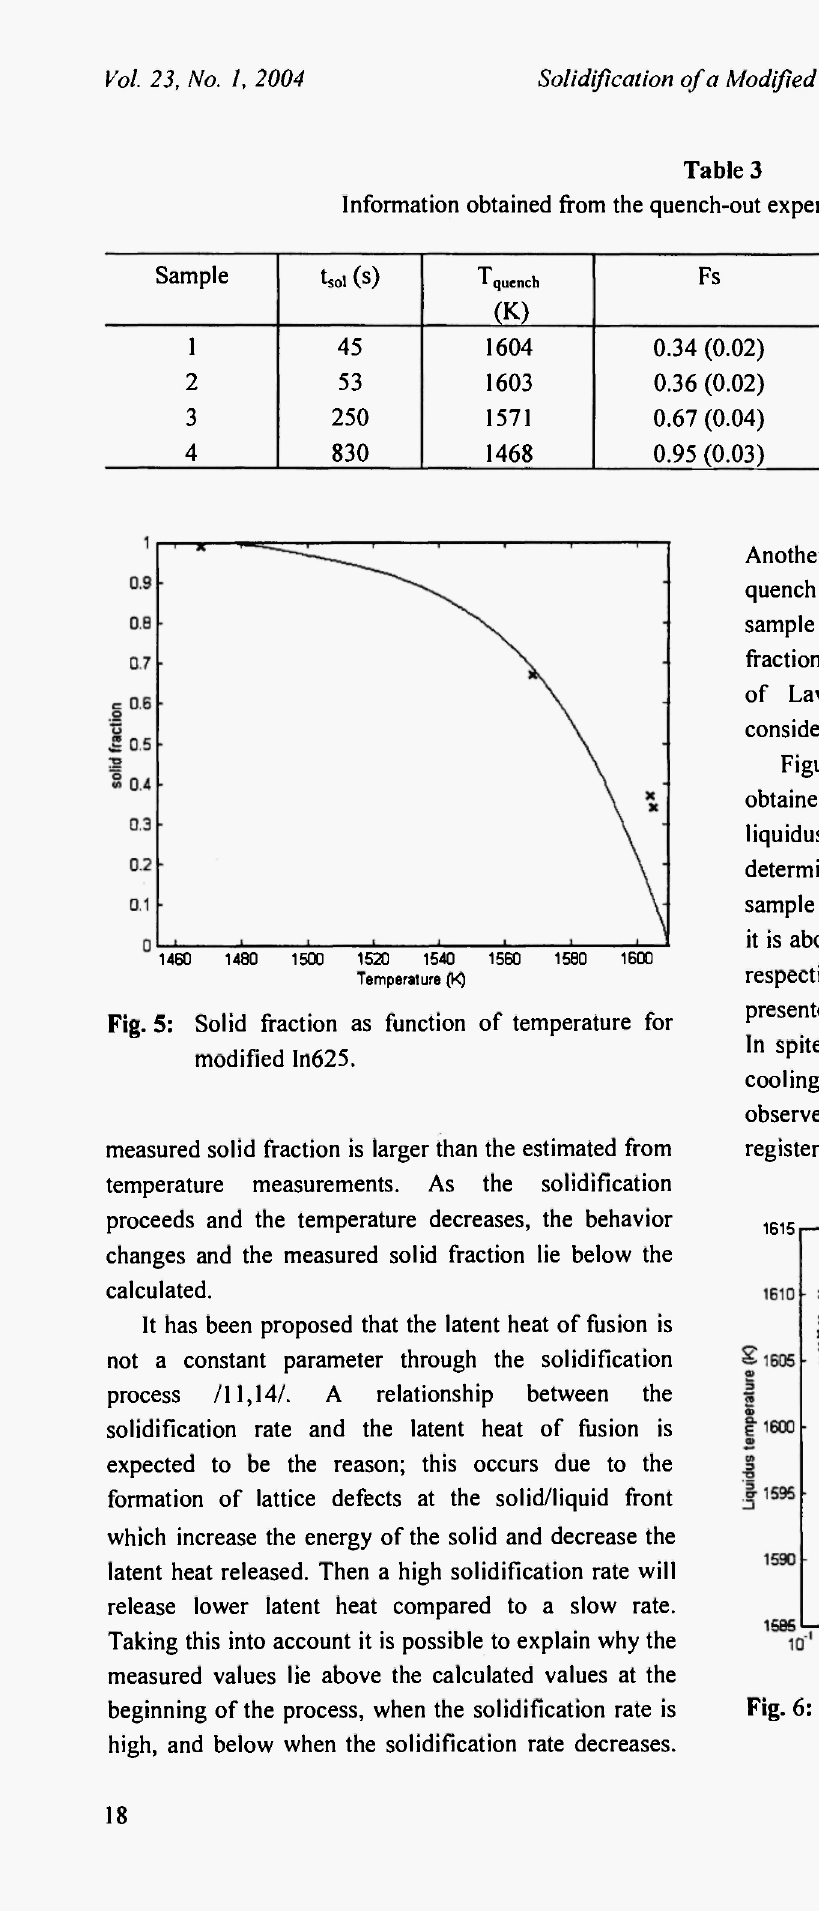
Fig. 6: Measured liquidus temperature as function of cooling